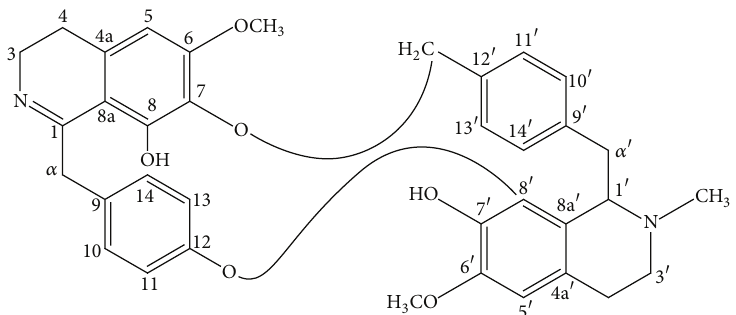
Figure 1: Structure of warifteine. The structure is based on data previously published [7,